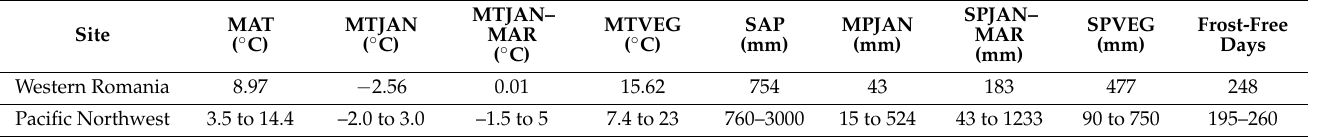
Table 2. Comparative climatic data for Douglas fir forest genetic resources from western Romania and at the natural distribution range in Pacific